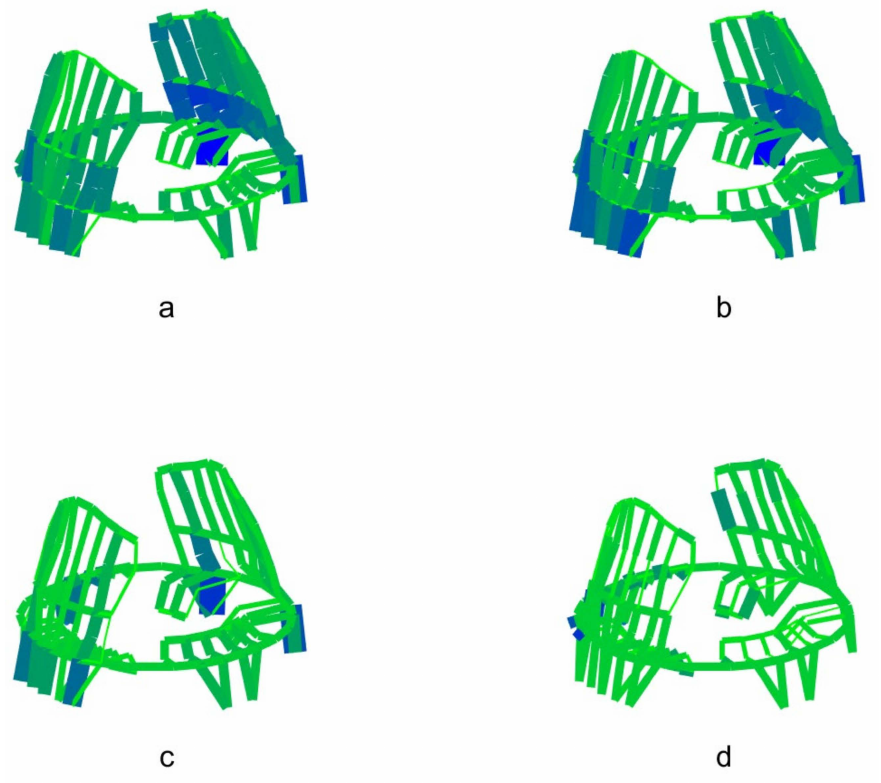
Figure 10. Three-dimensional evacuation routes. ( a ) ACO. ( b ) HMERP. ( c ) HDAFSA. ( d )